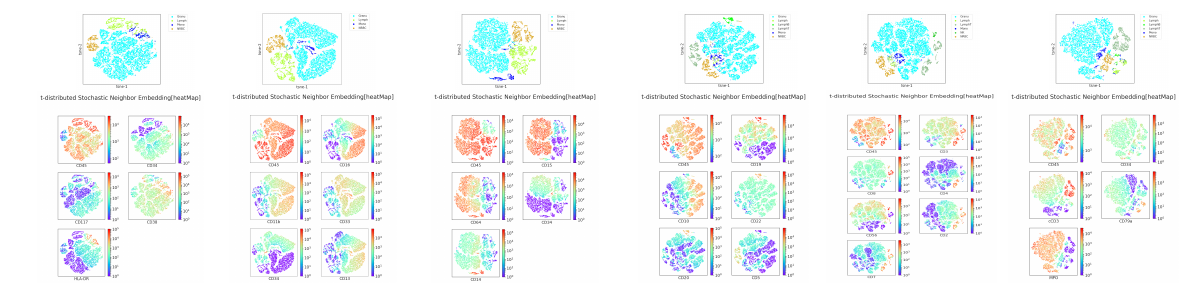
Figure 4. The representative scatter diagram, heat map, and TSNE plot of normal control. ( A ) Scatter diagram; ( B ) heat map; and ( C ) TSNE heat